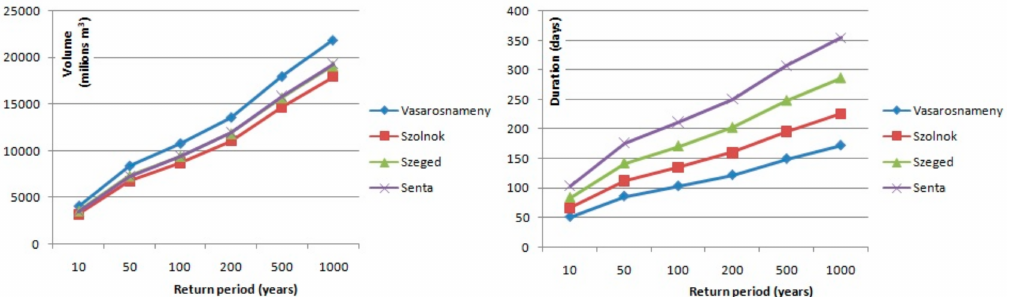
Figure 7. Flood volumes and durations of the Sava River in the Pannonian Basin.